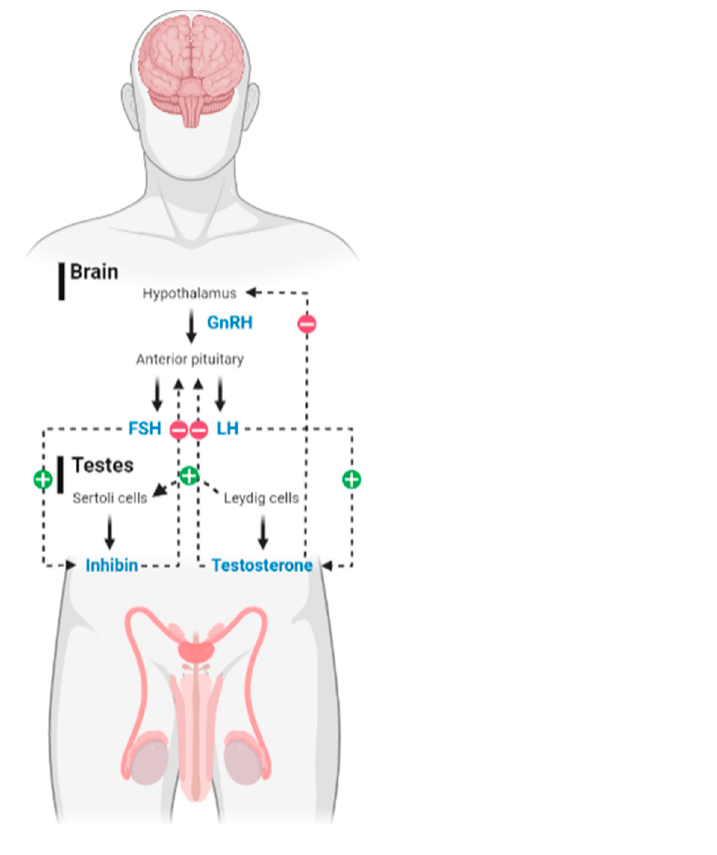
closing the cycle. T acts in both classical and non-classical routes in SCs [31,32]: by direct changes in gene expression; or via activation of kinases that may be involved in vital processes re- lated to spermatogenesis [33]. Throughout the classical T signaling route, T diffuses across the plasma membrane and interacts with the AR. In turn, AR will reach the nucleus and interact with certain DNA sequences known as androgen response elements, modulating gene expression, and impacting cellular function [31–33]. In addition to the classic route, there are at least two significant non-classical T action pathways in SCs. T interacts with the AR in the non-classical kinase activation route, which enables it to draw in and activate